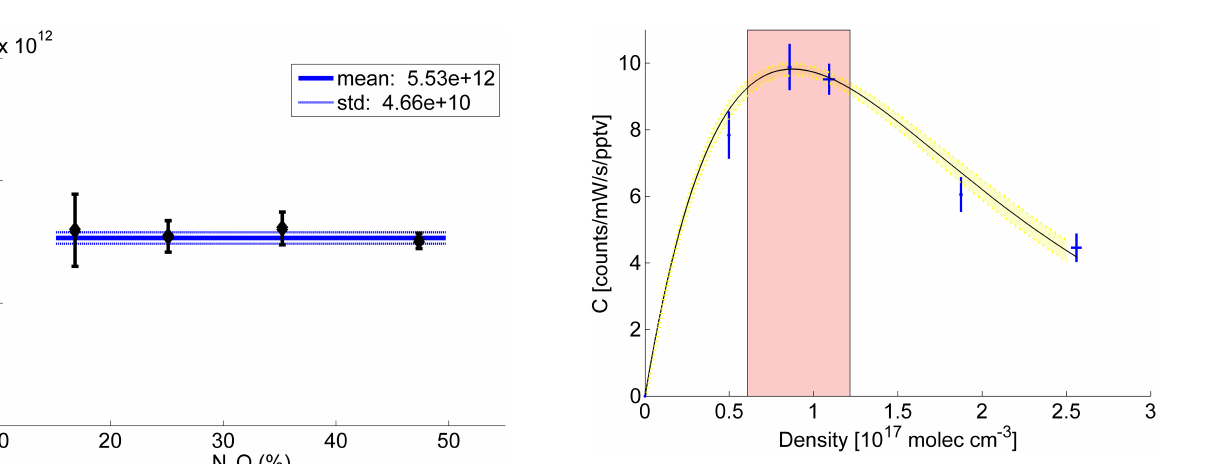
Fig. 6. Pressure dependency of the instrument sensitivity. Highest sensitivity is found between 2.5 and 5mbar in the highlighted red area. Points shown are mean values of individual calibrations; the error bars indicate the variability between the individual calibra- tions. The black line represents a chi-square fit and the yellow area indicates the